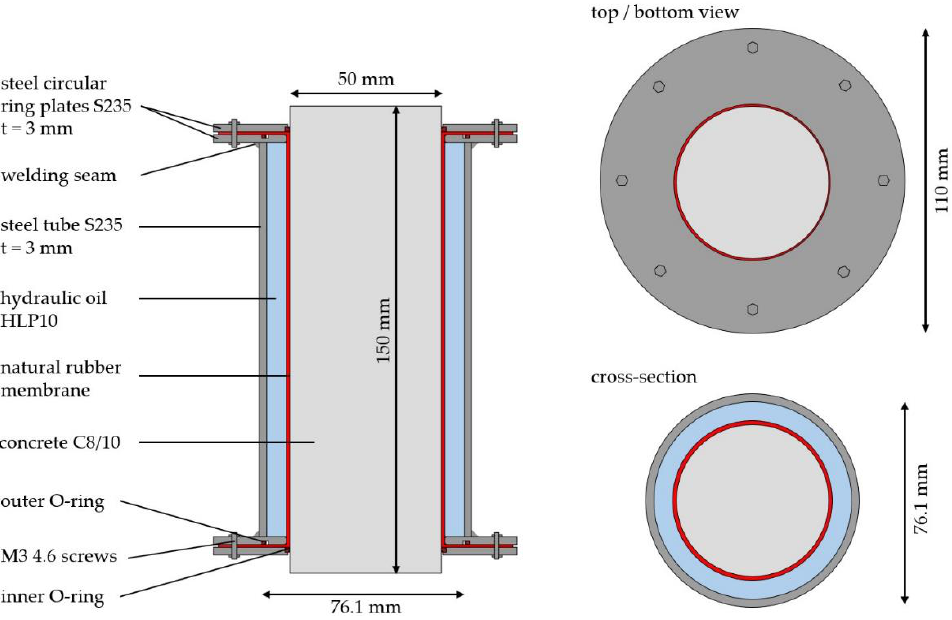
Figure 4. Design of the prototype.